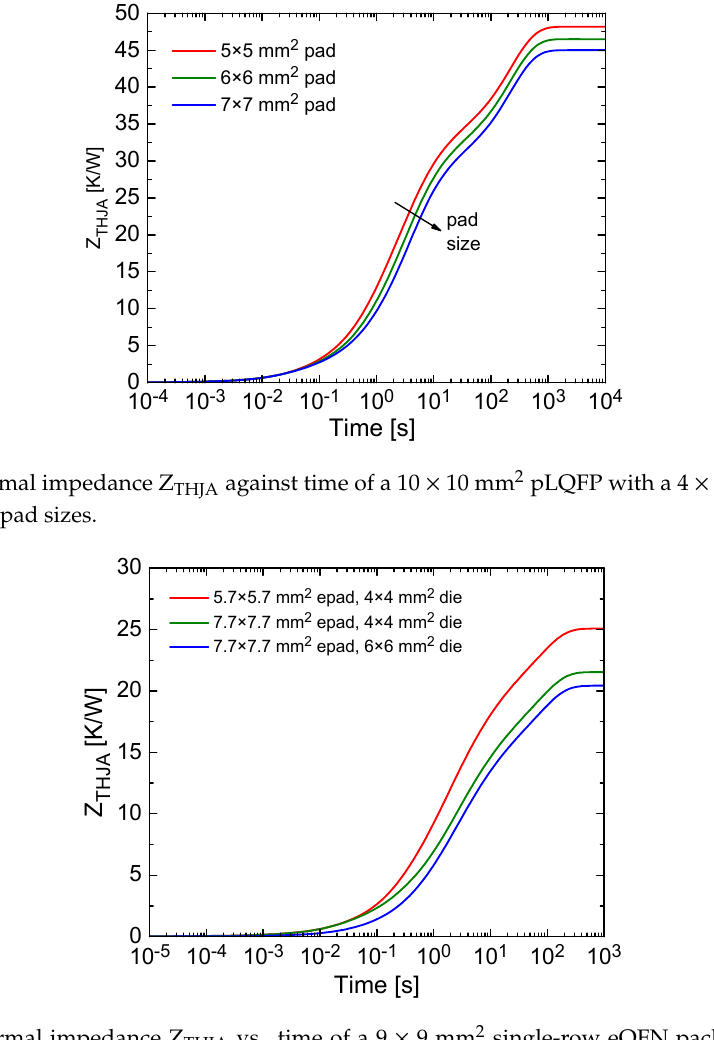
epad size Figure 10. Thermal impedance Z THJA of a 10.3 × 7.5 mm 2 PowerSSO-36 L with a 4.09 × 3.17 mm 2 die for four different epad sizes. 4.3. Comparison with FloTHERM First and foremost, it must be underlined that the user-friendly graphical interface of TRIC allows avoiding the long, painstaking, and prone-to-error geometry/mesh construction process often required by conventional numerical tools, thus markedly lowering the pre-processing effort and time. As far as the accuracy and efficiency of TRIC are concerned, they were estimated by comparison with the widely used commercial software FloTHERM. The tools share the same geometry simplifications and BCs. The favorable matching between the thermal metrics determined by TRAC and the FV software was already shown in [11] for eLQFPs, eTQFPs, and eQFN packages; the slight discrepancy (typically <2%, the maximum value being around 3%) was mainly attributed to the different mesh styles of the simulators. Evidence of the good agreement is also provided in Figure 11, which shows the (static) maps of temperature rise over ambient (T amb = 20 °C) determined for three eTQFPs with dies dissipating 1 W in the ϑ JA -related ambient; in particular, (a) corresponds to a 14 × 14 mm 2 package size with a 9 × 9 mm 2 epad and a 3 × 3 mm 2 die; (b) to a 10 × 10 mm 2 package with a 6 × 6 mm 2 epad and a 4 × 4 mm 2 die; (c) to a 10 × 10 mm 2 package with a 6 × 6 mm 2 epad and a 2 × 2 mm 2 die.